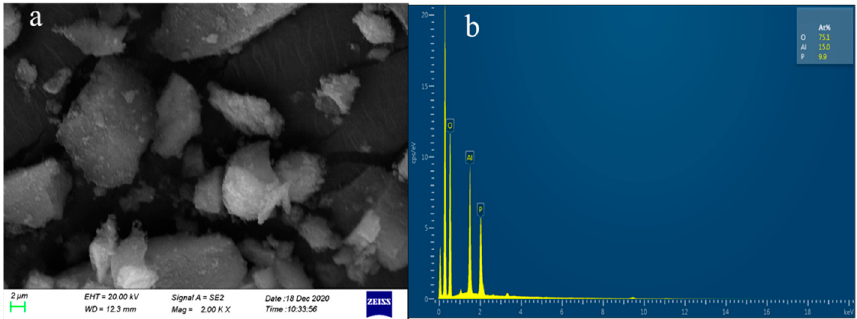
Figure 8. SEM images of phosphate precipitation in aluminum–air batteries ( a ) and EDS results ( b ).